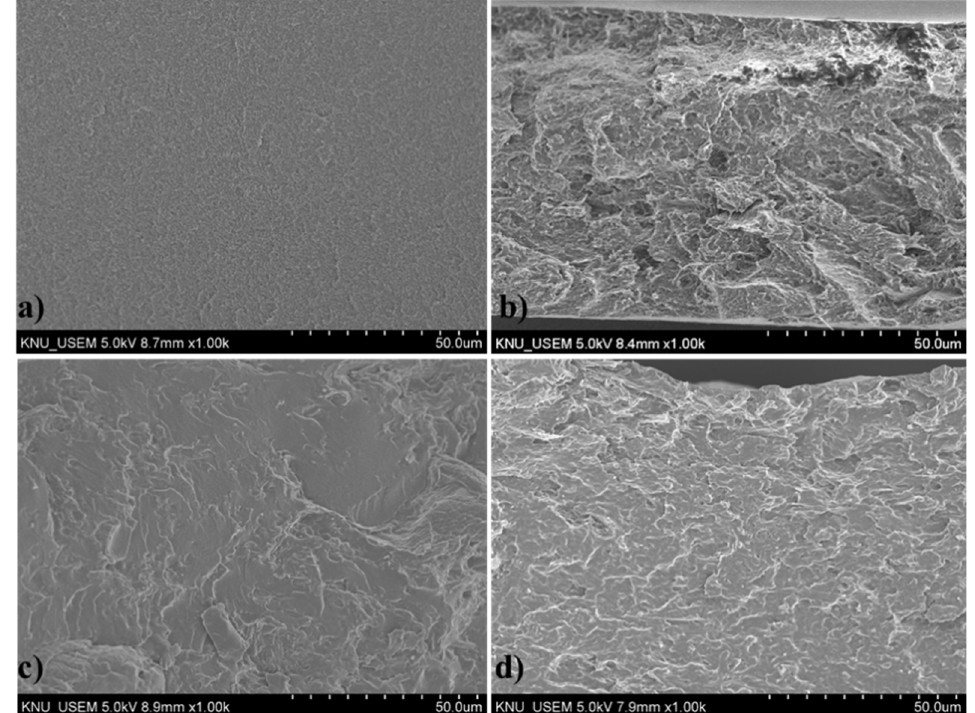
Figure 8. SEM images of the fractured surface of Neat CA ( a ), CA/TC/CNF5 (Acetone) ( b ),